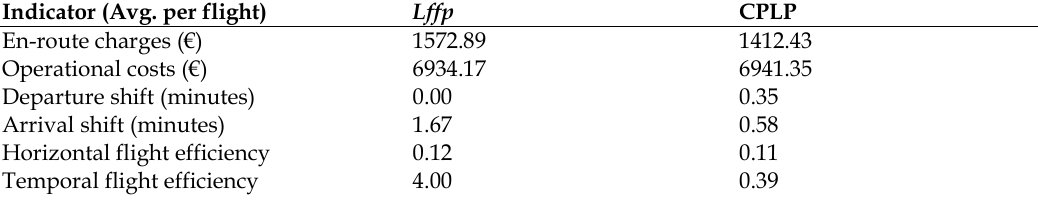
Table 2. Performance indicator values for the obtained route and departure time assignments with (CPLP) and without (Lffp) unit rate